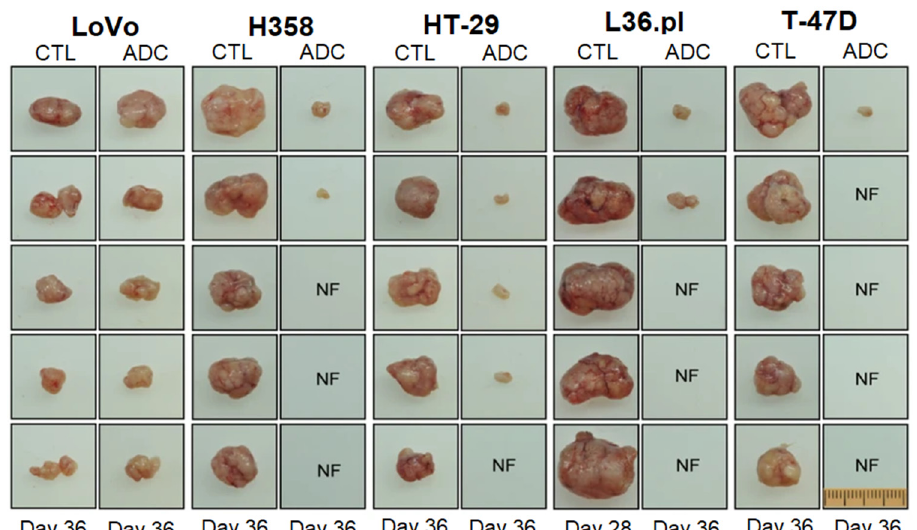
Figure 8. The effect of anti-RON ADC in the inhibition of tumor growth in LoVo colorectal, H358 non-small cell lung, HT-29 colon, L36.pl pancreatic, and T-47D breast xenograft tumor models. The control (CTL) was xenograft tumors mediated by LoVo cells. NF refers to no observed tumor. Adapted from [114] under the terms of the Creative Commons CC BY license.